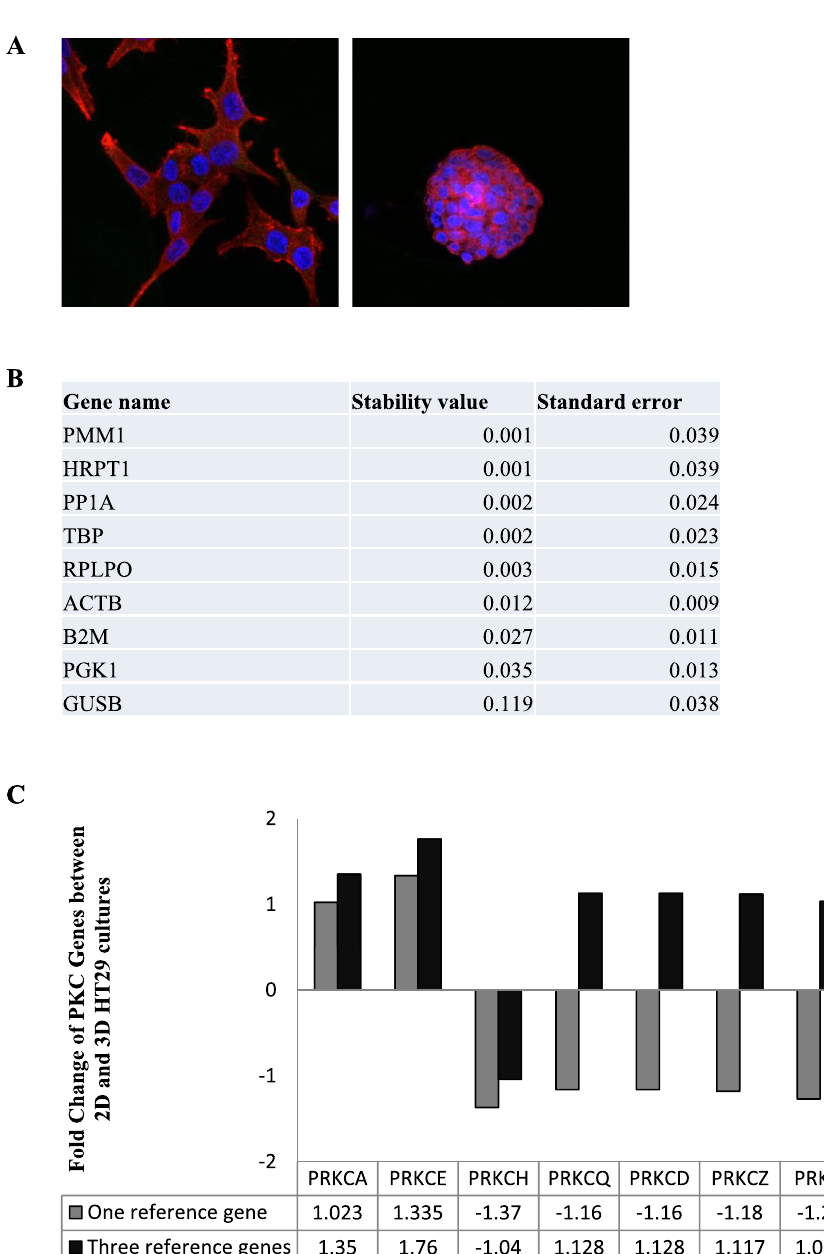
Figure 2. Reference genes in 2-dimensional and 3-dimensional HT29 cultures. The stability of the nine candidate reference genes between 2D and 3D HT29 cultures was analysed using NormFinder. ( A ) Immunofluorescence images of HT29 cells in 2D (100X) (left panel) and 3D (right panel) cell cultures (63X). ( B ) Table displaying the stability levels of the nine candidate reference genes between the 2D and 3D cultures. ( C ) Graph representing the fold change of PKC coding genes in 3D cultures compared to 2D cultures when using one reference gene (PMM1) versus three reference genes (PMM1, HRPT1 and